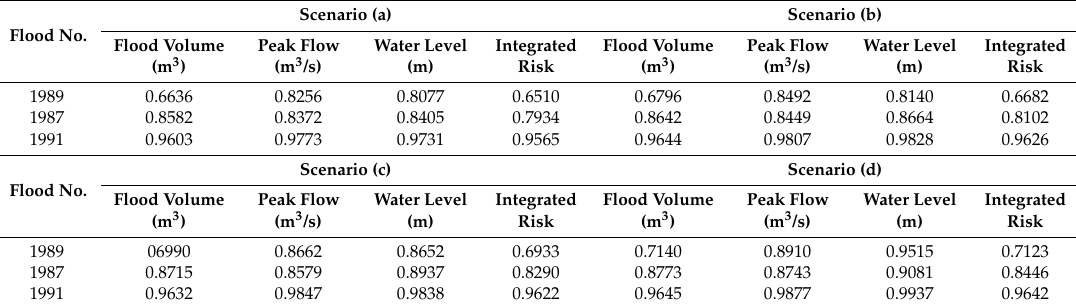
Table 6. The risk results of different polder distribution